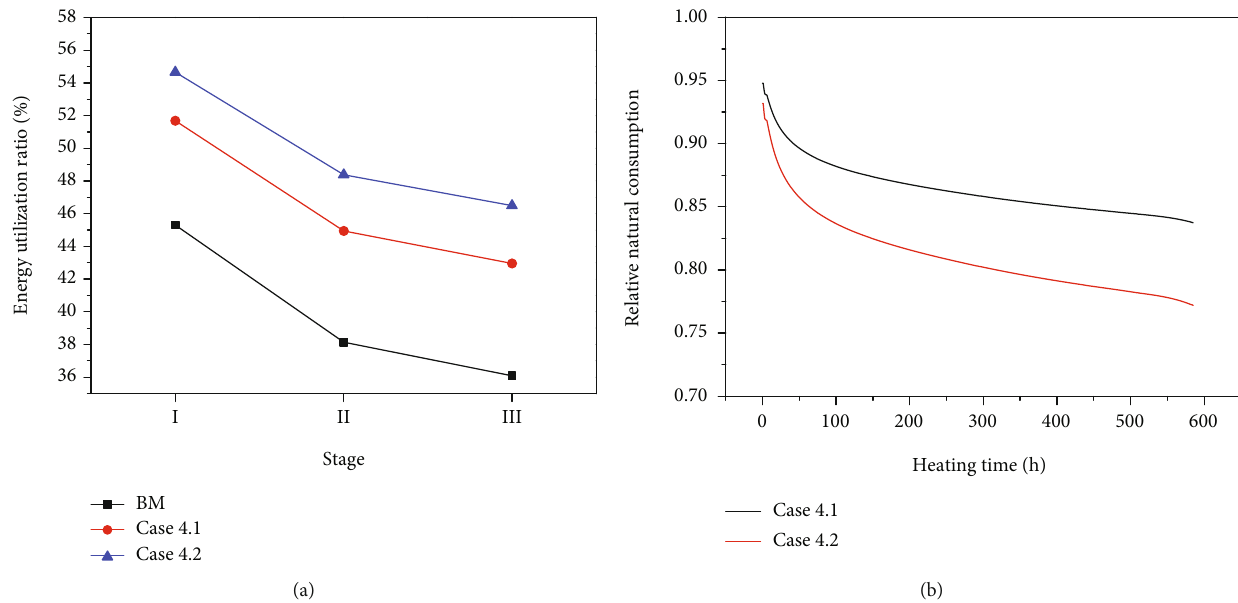
Figure 8: Energy utilization ratio (a) and relative natural gas consumption ( G